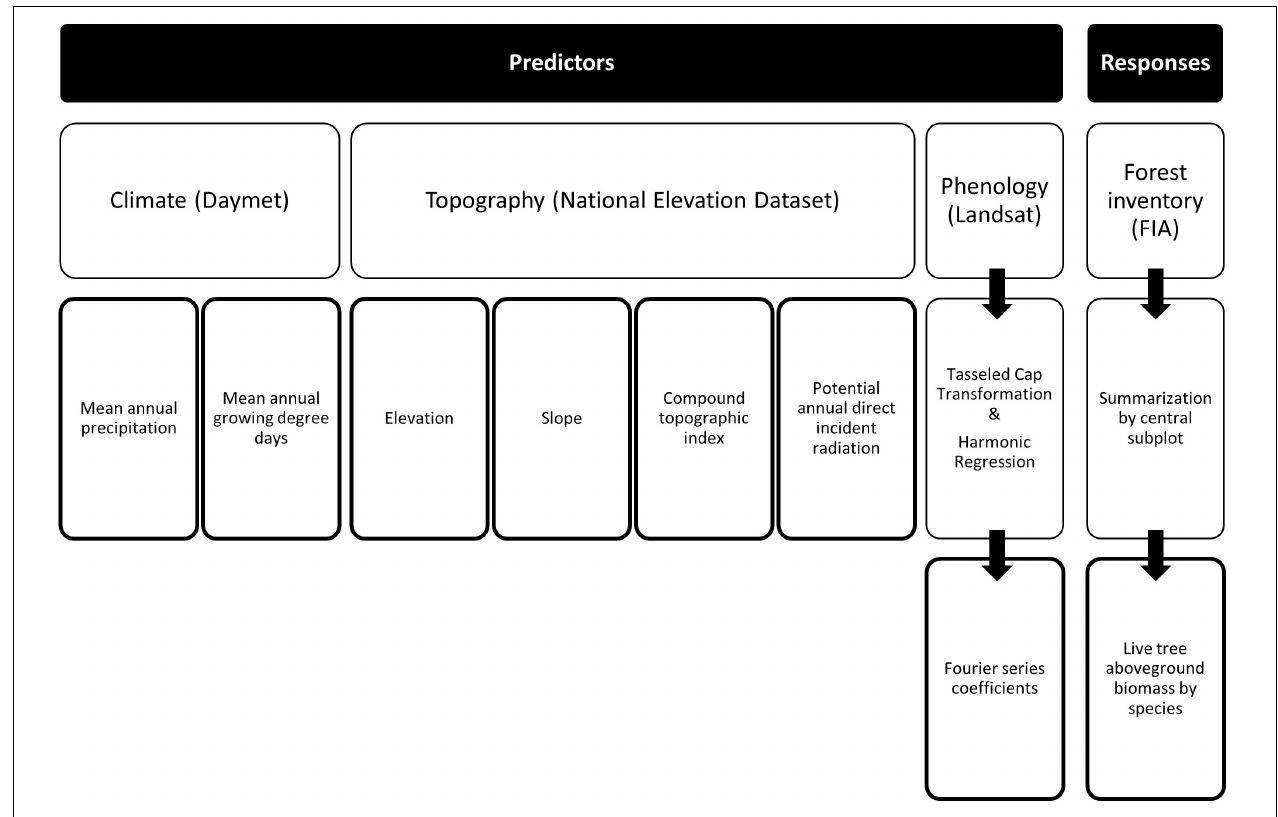
FIGURE 2 | Summarization of the source and generation of predictor (auxiliary) and response (forest inventory) variables used in the development of kNN mapping of